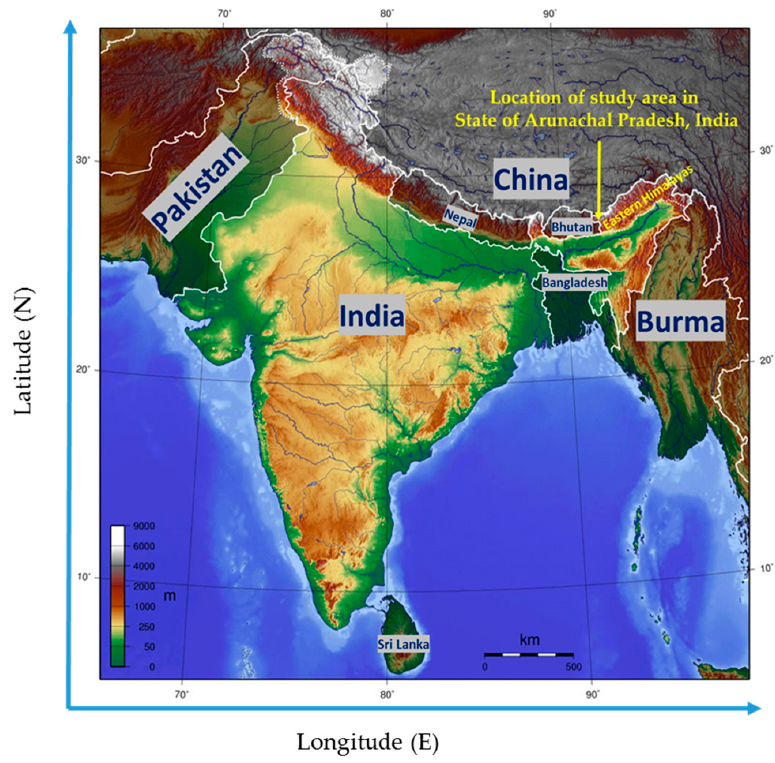
Figure 1. Location of the study area at the Zemithang region in the state of Arunachal Pradesh, India pointed by the yellow arrow (map not to scale).